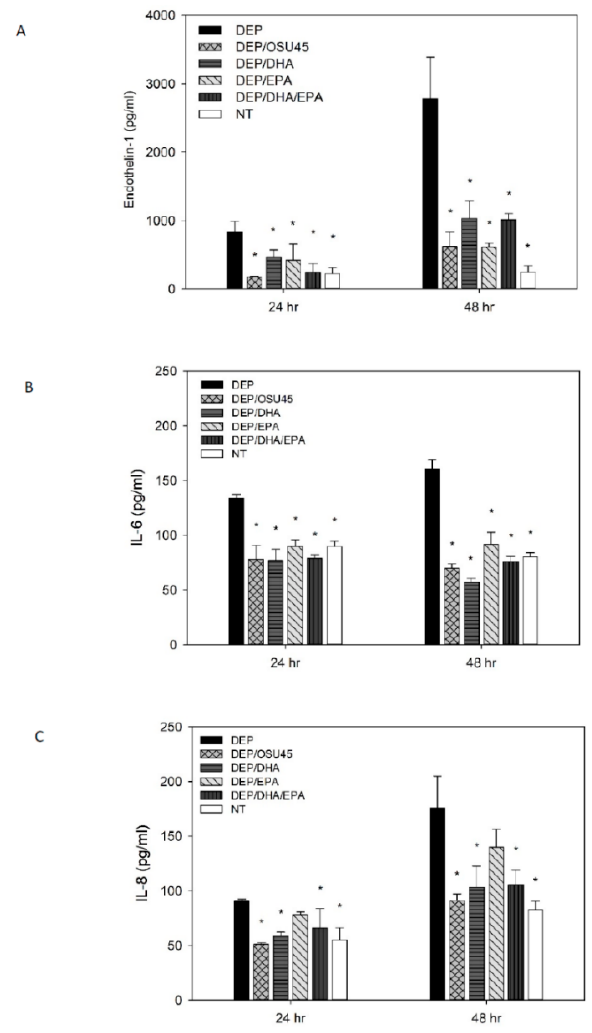
Figure 2. The effect of pure polyunsaturated fatty acids ( ω -3 PUFAs), docosahexaenoic acid (DHA), and eicosapentaenoic acid (EPA), their combination (DHA/EPA) or oil formulation containing both (OSU45) at a concentration of 100 µ M on DEP-induced release of endothelin-1 (ET-1) ( A ), interleukin-6 (IL-6) ( B ) and interleukin-8 (IL-8) ( C ). NT is the no treatment control without DEP and without ω -3 PUFA treatment. * Treatment is significantly different ( p < 0.05) from DEP.